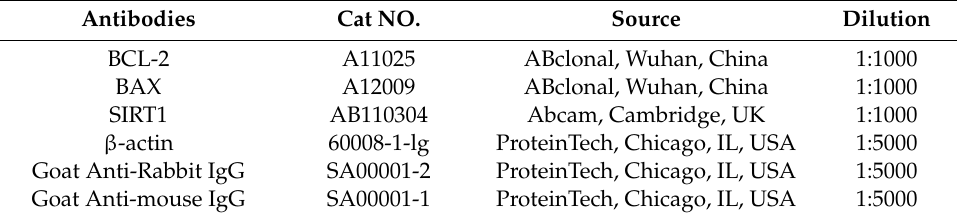
Table 2. Details of primary and secondary antibodies used for western blot in this